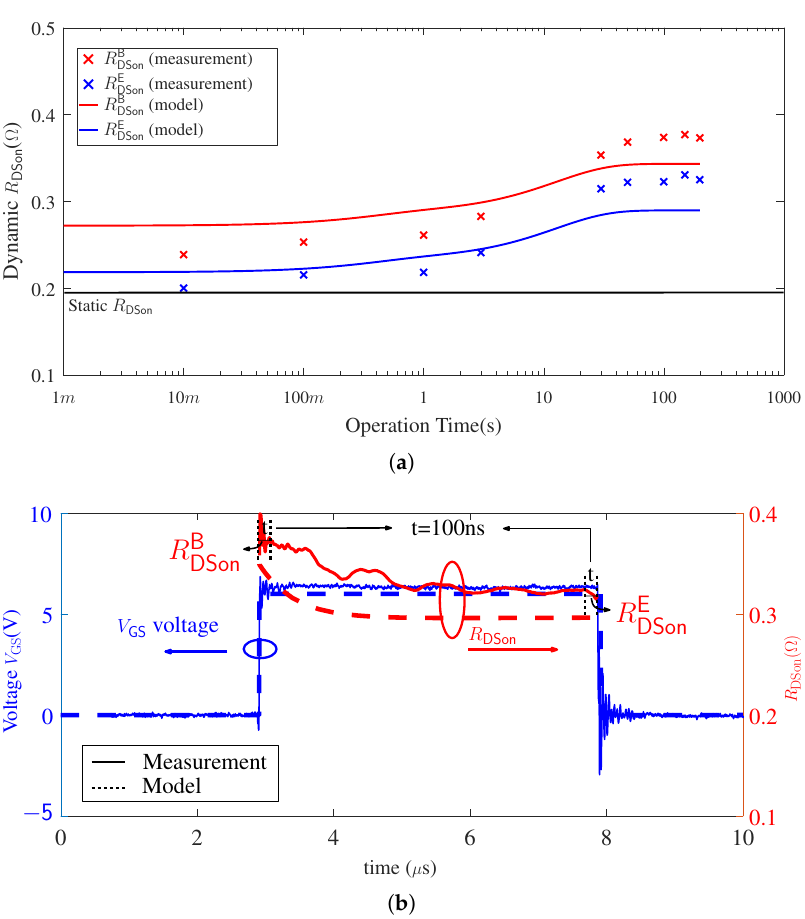
Figure 13. Comparison between model and measurement for GaN device dynamic R DSon value when device is switched at 100 kHz, D = 50%: ( a ) Transient and steady state. ( b ) At one switching cycle in steady